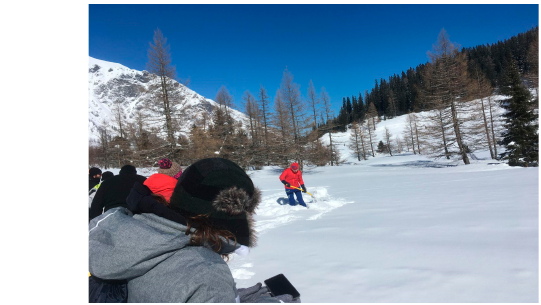
Figure 1. The sampling site at Kolm Saigurn, Austria. Left . Map of the study location (unit distance of 100 km; Google Maps). Right . Photo of the sampling area.